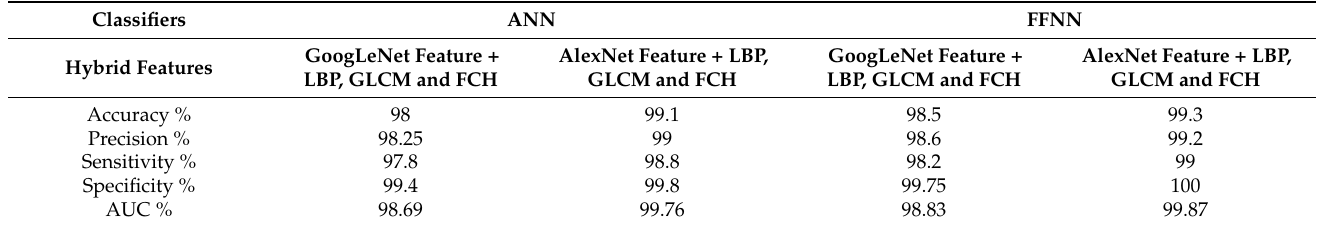
Table 7. Results of dataset evaluation by ANN and FFNN based on hybrid features.